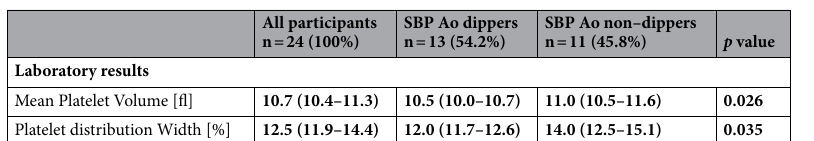
Table 3. Participants without hypertension in 24-h BP measurement. Comparison of the dippers and the non- dippers. Data presented as median (IQR)/n (%). Bold values denote statistical significance at the p < 0.05 level.